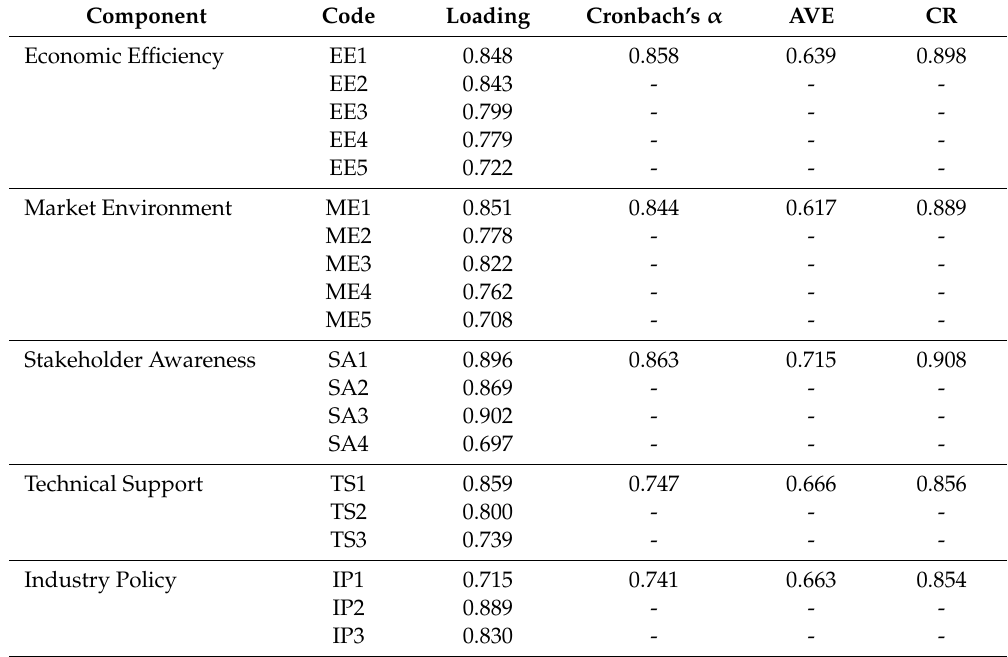
Table 6. Assessment results of reliability analysis and convergent validity.